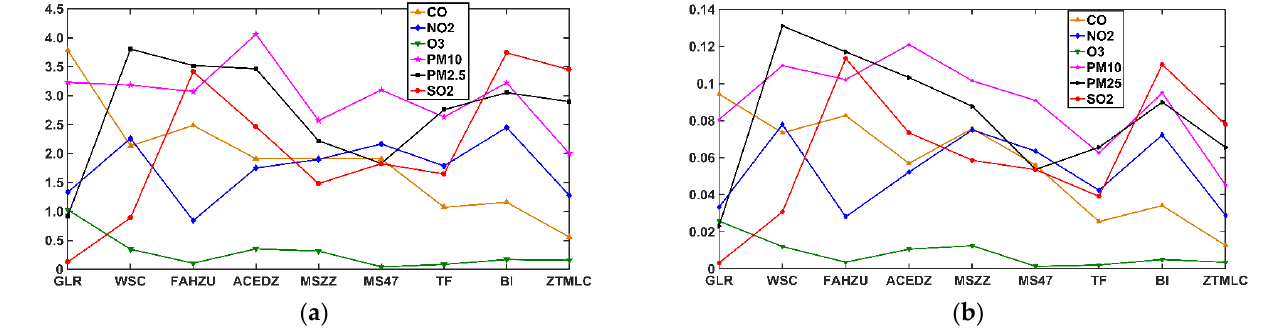
χ values under CDFA analysis of shuffled series in each station for 0 20 q ≤ ≤ . Figure 6. and 2 shuff χ value in 9 stations, ( b ) 2 χ value in 9 ( a ) 2 shuff shuff